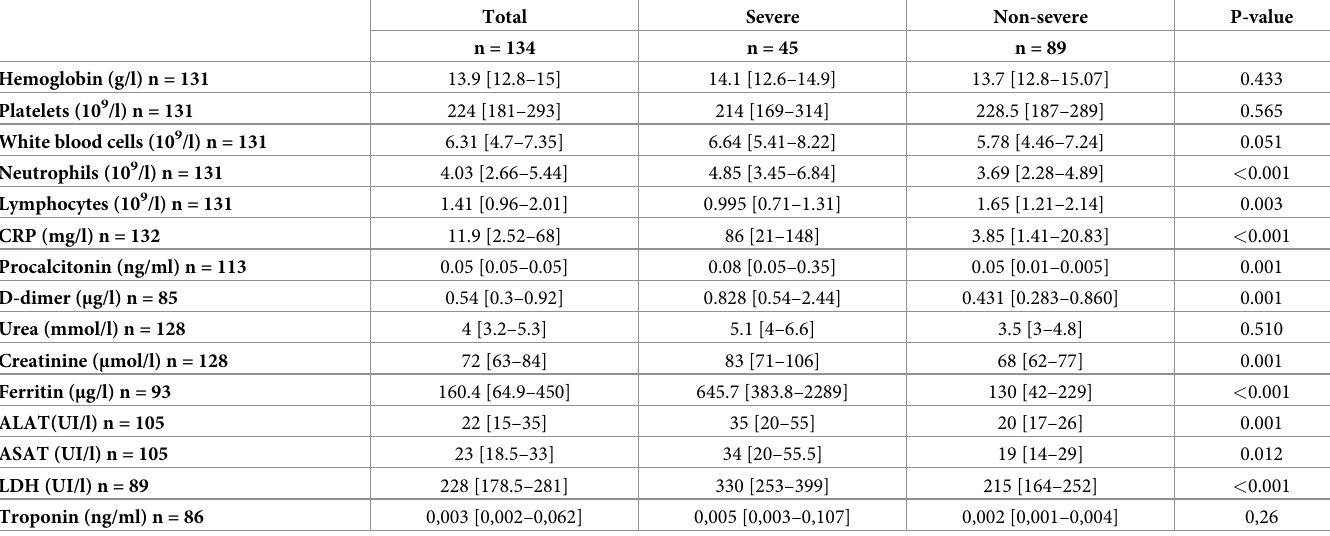
Table 2. Laboratory findings of patients on admission.